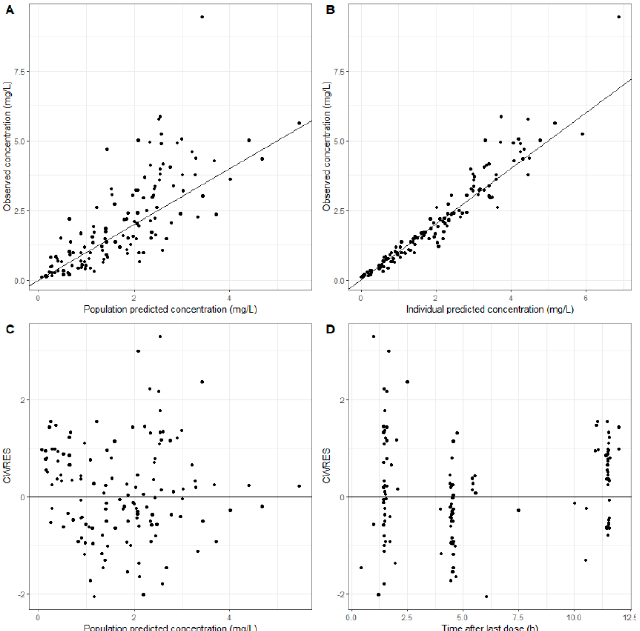
Figure 2. Goodness-of-fit plots for the final model for ciprofloxacin concentrations in critically ill patients. ( A ) Population-predicted ciprofloxacin concentrations vs. observed ciprofloxacin concen- trations. ( B ) Individual-predicted ciprofloxacin concentrations vs. observed ciprofloxacin concen- trations. ( C ) Conditional weighted residuals (CWRES) vs. population-predicted ciprofloxacin con- centrations. ( D ) Conditional weighted residuals (CWRES) vs. time after last dose.